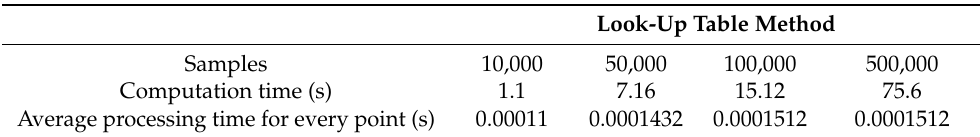
Table 10. Comparisons of grouping the eight-segment layers with different samples using the look-up table method.